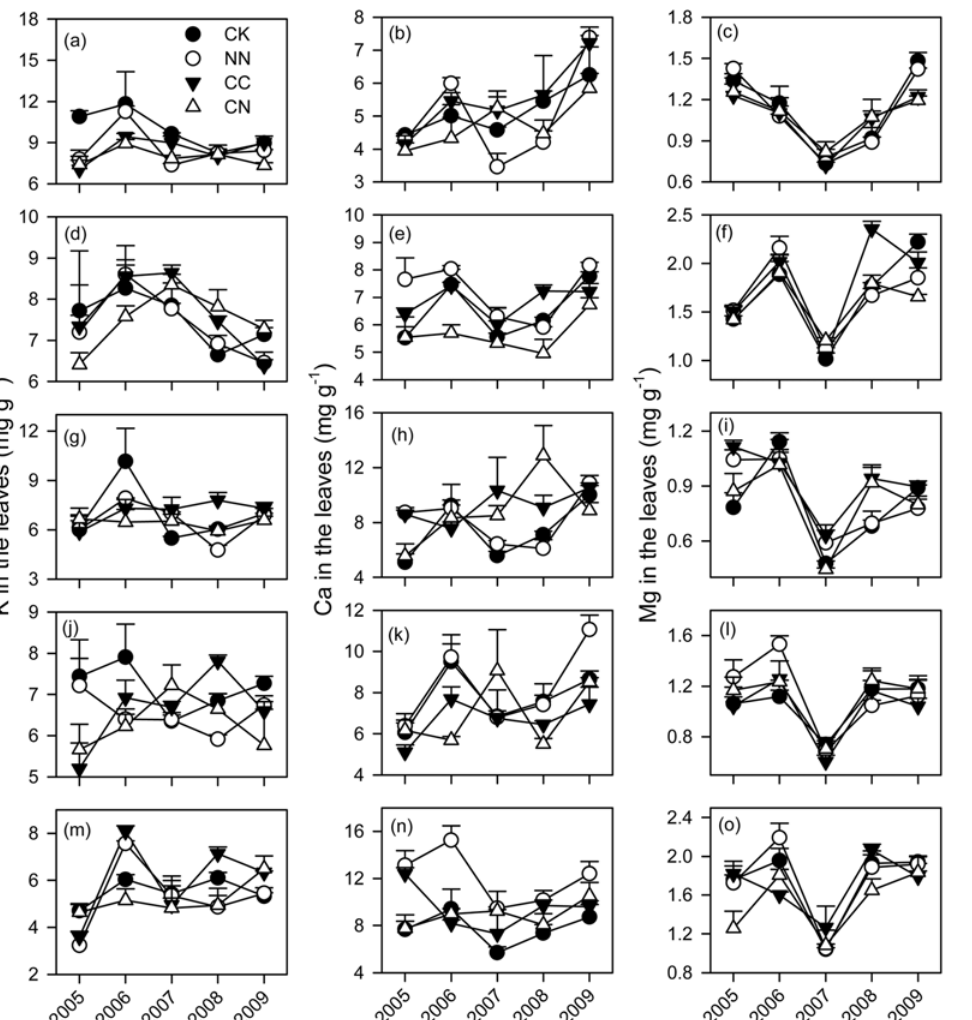
Fig 1. Concentrations of base cations in the leaves of five subtropical tree species exposed to different CO 2 and N treatments from 2005 to 2009. Each error bar is one standard error. CK, control; NN, ambient CO 2 with N fertilizer; CC, elevated CO 2 without N fertilizer; CN, elevated CO 2 with N fertilizer. (a-c) A . acuminatissima ; (d-f) S . hancei ; (g-i) C . hystrix ; (j-l) O . pinnata ; (m-o) S . superba